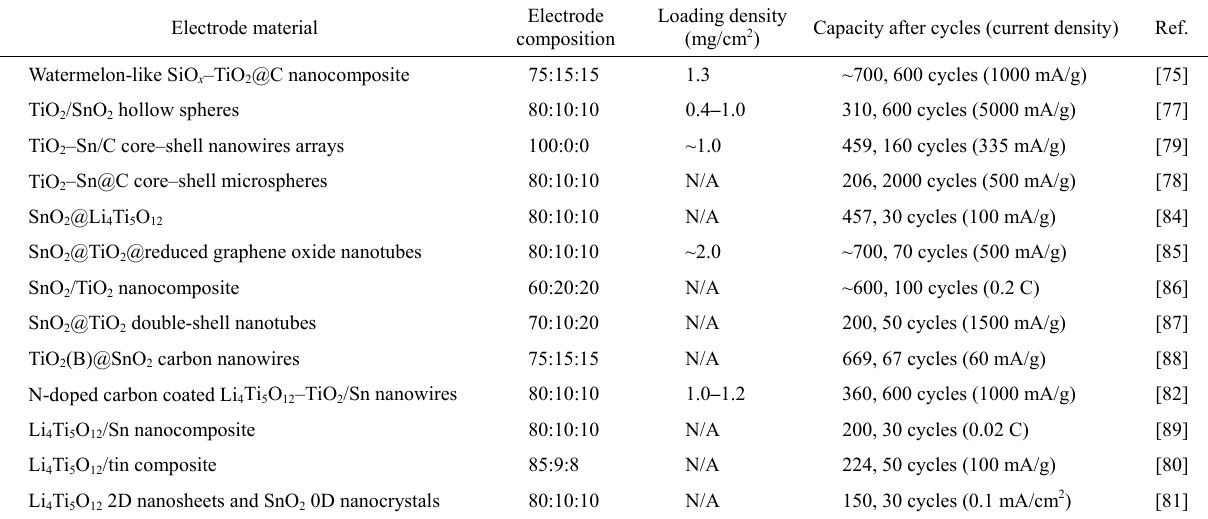
Table 2 Comparison of the electrochemical performances of Ti-based hybrid nanocomposites with alloying-type anodes. Their electrode compositions are listed using the mass ratio of active materials: conductive carbon: binder Electrode Loading density Electrode material Capacity after cycles (current density) composition (mg/cm 2 )